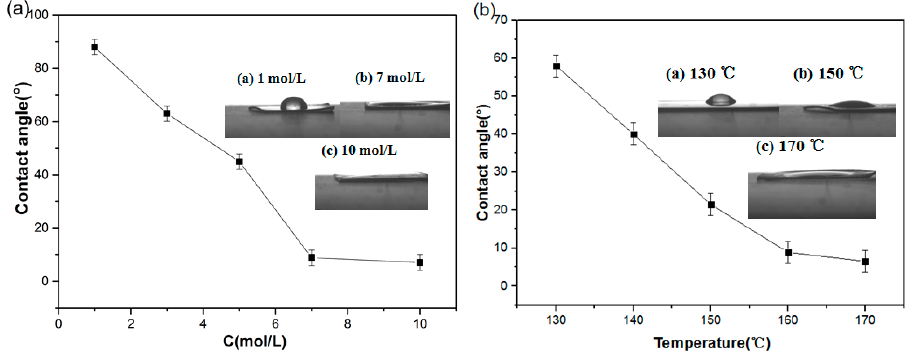
Figure 8. Hydrophilic property of TiO 2 nanotubes network prepared at ( a ) different concentration of NaOH; ( b ) different temperatures.